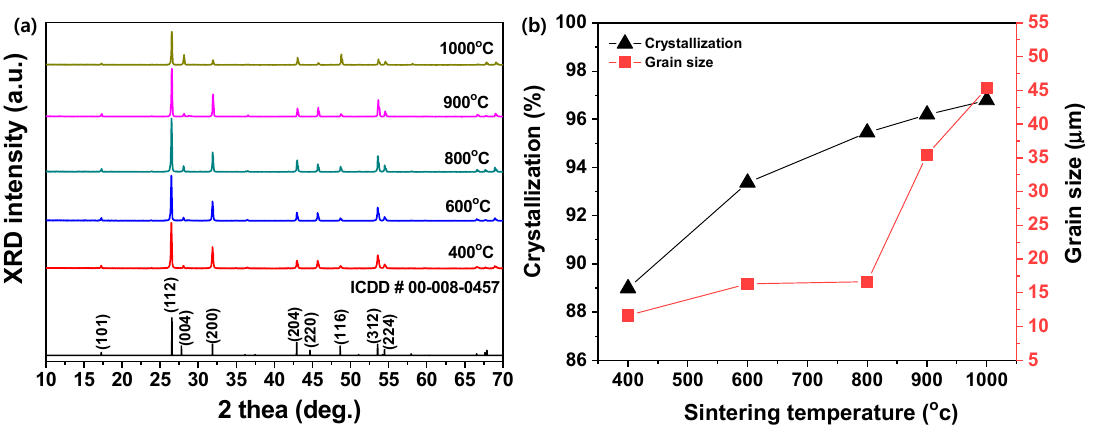
Figure 1. ( a ) XRD patterns and ( b ) crystallization and grain size of BaWO 4 powders with various sintering temperatures (400, 600, 800, 900, 1000 °C).